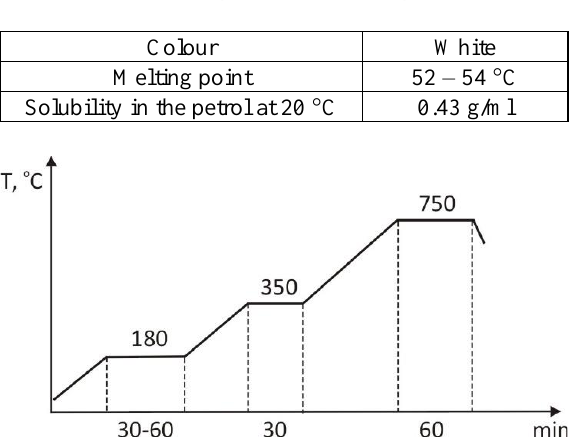
Figure 5. Schematic diagram of dewaxing and